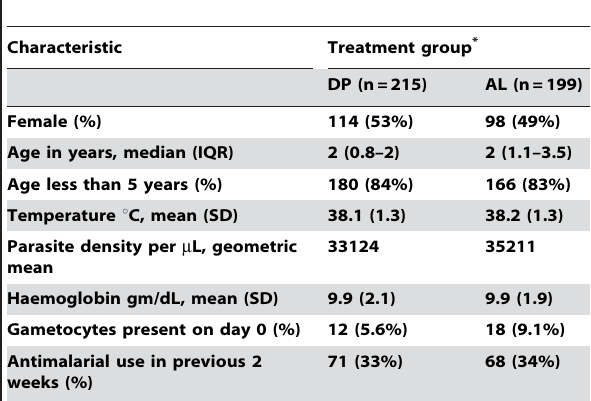
Table 1. Baseline characteristics of patients receiving either dihydroartemisinin-piperaqine (DP) or artemether-